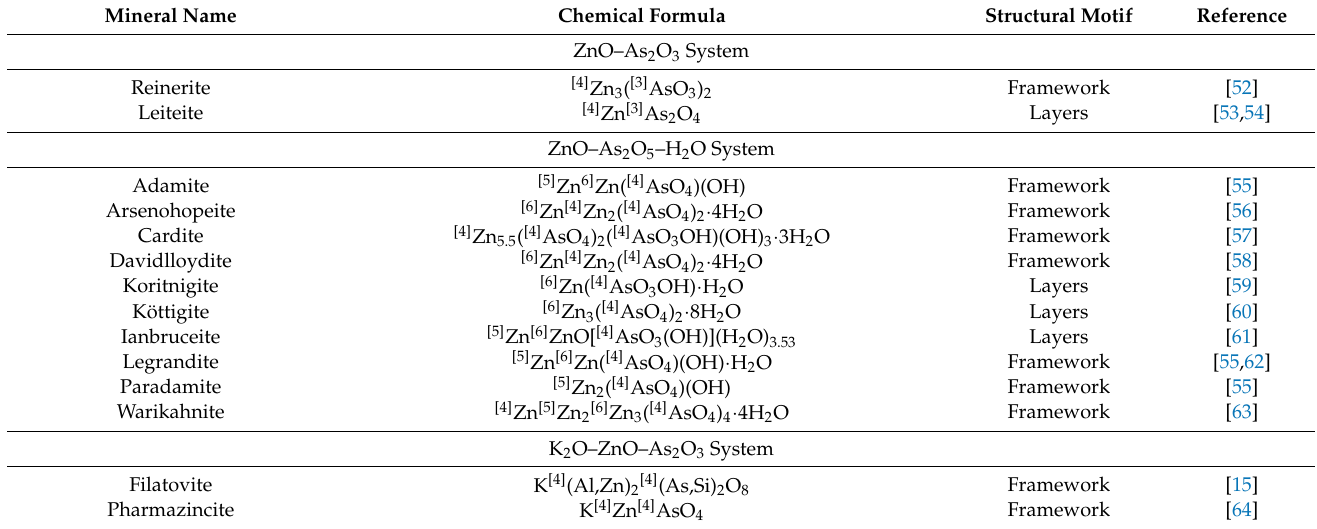
Table 3. List of minerals containing ZnO n ( n = 4, 5, 6) and AsO n ( n = 3, 4)